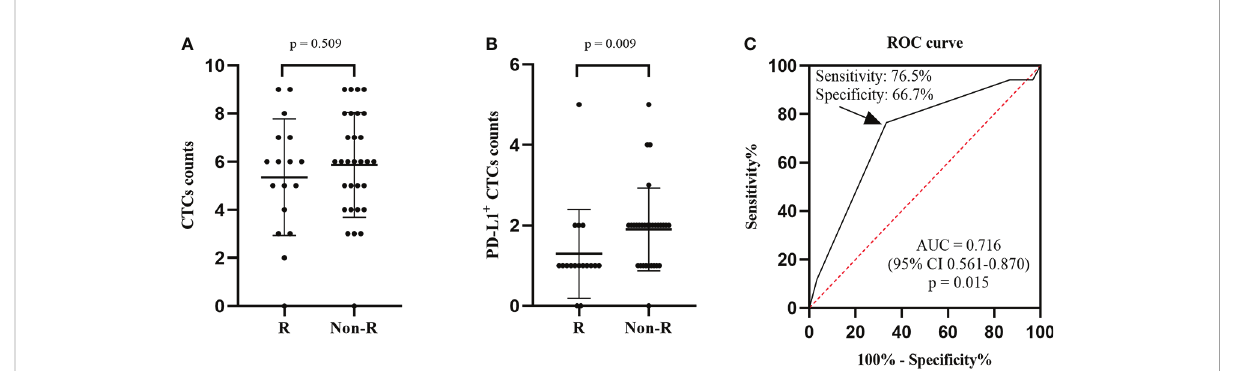
FIGURE 2 Comparison of the number of CTCs (A) and PD-L1 + CTCs (B) between the nonresponse group and response group. (C) ROC curve was adopted to investigate the predictive value of PD-L1 + CTC counts. When applying a cut-off of 2 PD-L1 + CTCs, a speci fi city of 65.5%, a sensitivity of 76.5%, and an AUC of 0.710 were observed. R, responder; CTCs, circulating tumor cells; PD-L1, programmed death-ligand 1; ROC, receiver operating characteristic; CI, con fi dence interval; AUC, area under the